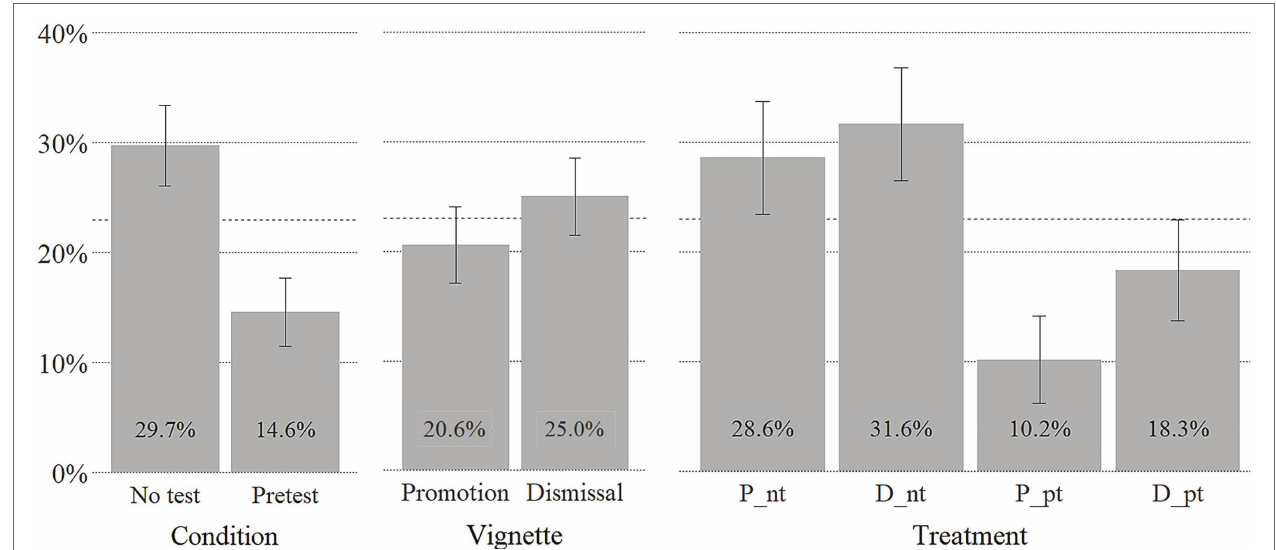
FIGURE 2 | Share (S) of participants delegating human resource (HR) decision to algorithm. Error bars denote ±1 SE; dashed line indicates sample mean of 23%.